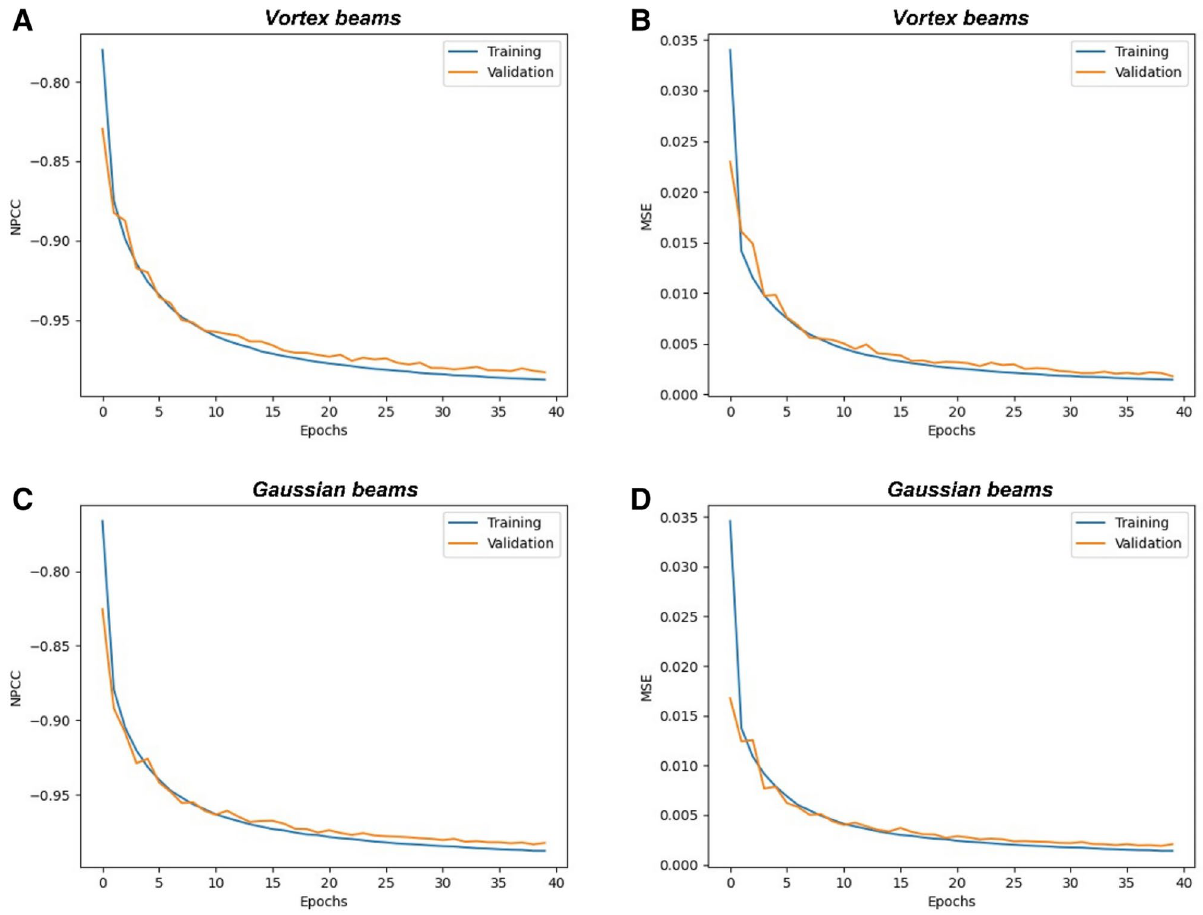
Figure 10. Shows the training and validation convergence graphs for the CNN used in the study. The convergence of the NPCC function for the image reconstruction process for both the vortex beams ( A , B ) and Gaussian beams ( C , D ) is shown. The reduction in the mean squared error (MSE) with each epoch is also In Table 1, the Experiment values for “Imaging using Gaussian beams” and “Imaging using vortex beams” were incorrect for the Parameters “MSE”, “PSNR”, “NPCC” and “Sørensen-Dice coefficient”. The original Table 1 and accompanying legend appear below.